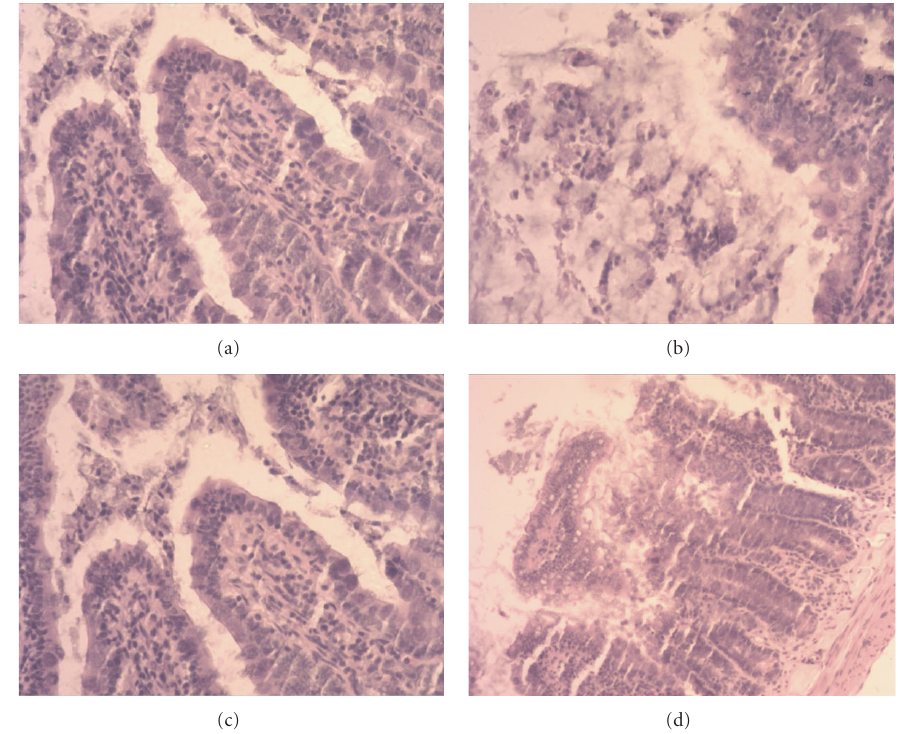
Figure 8: Histological findings of the intestinal mucosa. (a) Sham, (b) SAP, (c) SAP + LP17, (d) SAP +